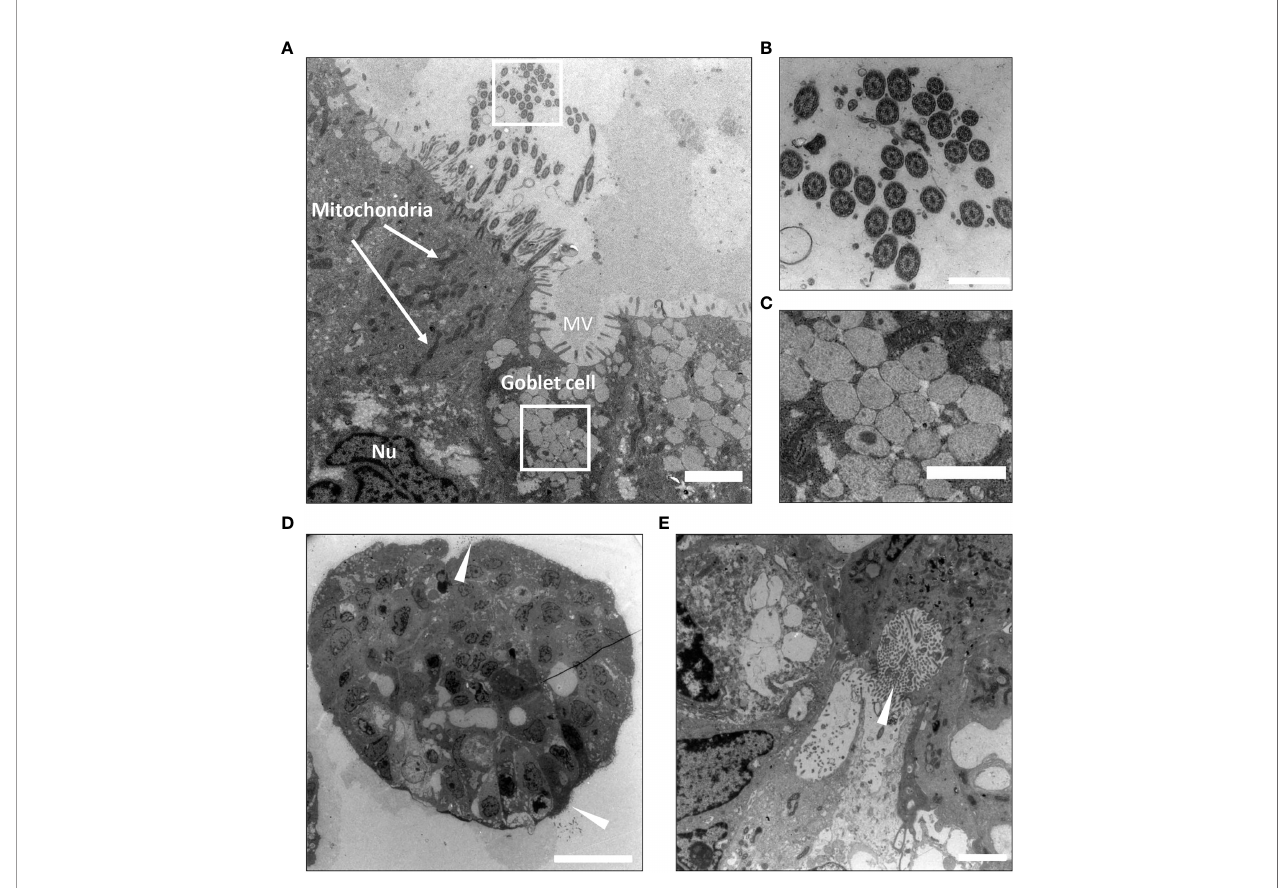
FIGURE 3 | Ultrastructural characterization of bronchiolar organoid tissues by Transmission Electron Microscopy (TEM). (A) Transmission electron micrograph display cross-section of a bronchiolar organoid. This image shows the characteristic pseudostrati fi ed airway epithelium, consisting of interspersed multi-ciliated and secretory goblet cells. Nu: nucleus. MV: microvilli. Scale bar equals 2000 nm. (B) Zoomed insert from (A) to show a cross-section of the motile cilia sprouting from the ciliated cell. The characteristic 9 + 2 arrangement of microtubules is clearly visible. Scale equals 500 nm. (C) Zoomed insert from (A) to show the electron-lucent granules of the secretory goblet cell. Scale bar equals 1000 nm. (D) Apical side-out orientated organoids. Ciliated cells are pointed (white arrowheads). Scale bar equals 10 µm. (E) Apical side-in orientated organoids. Ciliated cells are pointed (white arrowhead). Scale bar equals 2000 nm. The representative images displayed in these panels (A – E) are of organoids derived from Patient